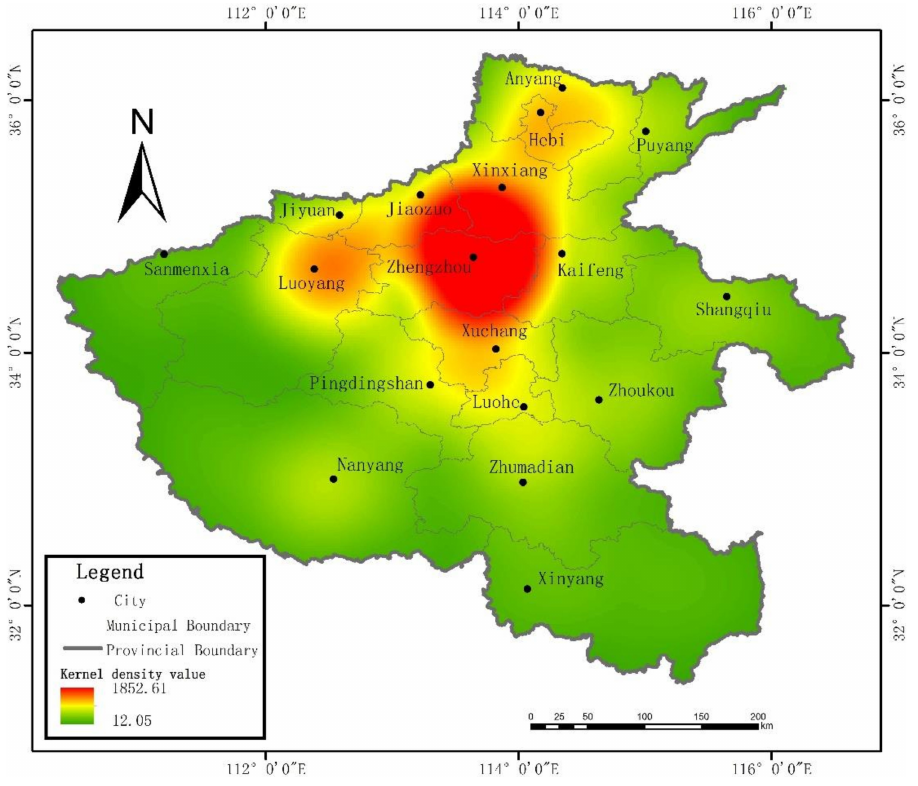
Figure 5. Heat map of urban boundary areas in Henan Province. Table 3. Accuracy verification of HNUB2018 and GUB